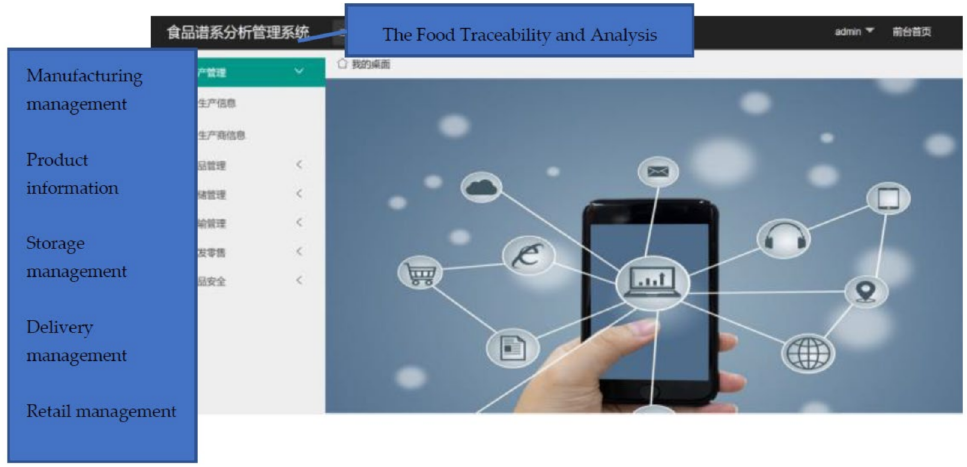
Figure 10. Client Application